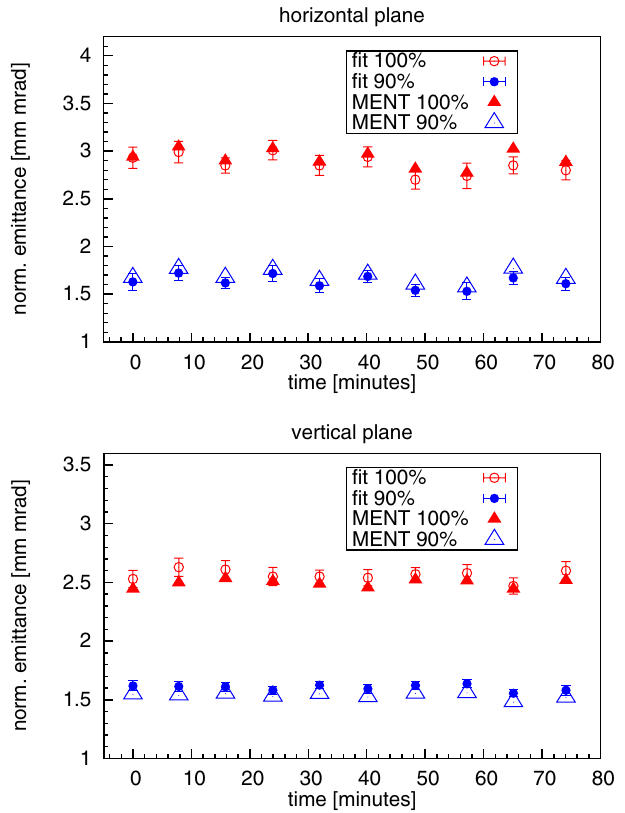
FIG. 5. (Color) Horizontal (top) and vertical (bottom) normal- ized rms emittances. The measurement is repeated 10 times during (cid:1) 1 : 5 h . Results obtained by fitting for 100% (red circle) and 90% (blue circle) beam intensity as well as by tomography (MENT) for 100% (red triangle) and 90% (blue triangle) inten- sity are shown. Error is the statistical error